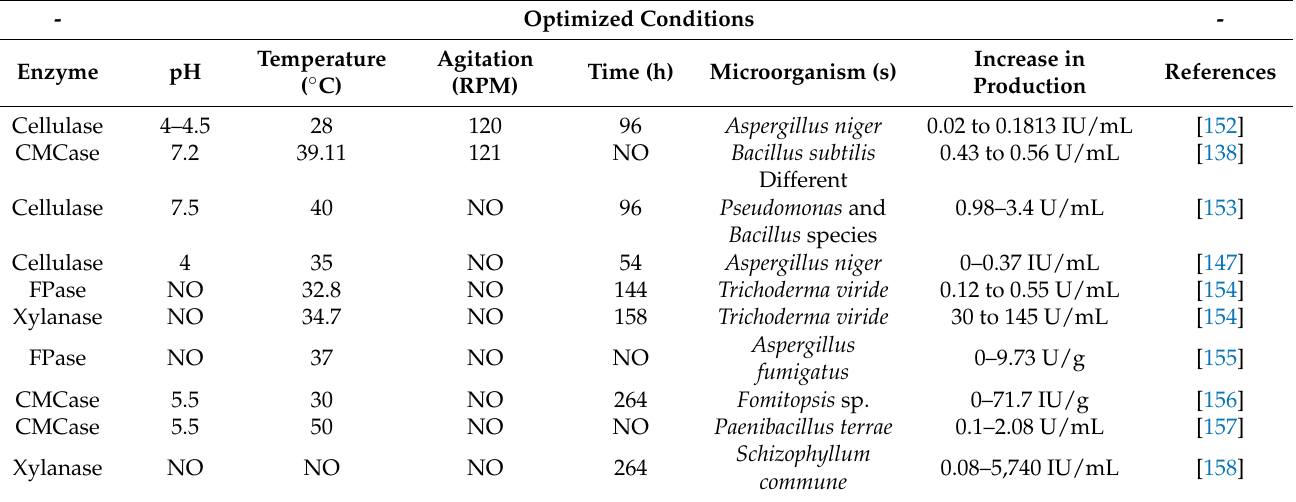
Table 4. Culture optimization techniques for lignocellulolytic enzyme production